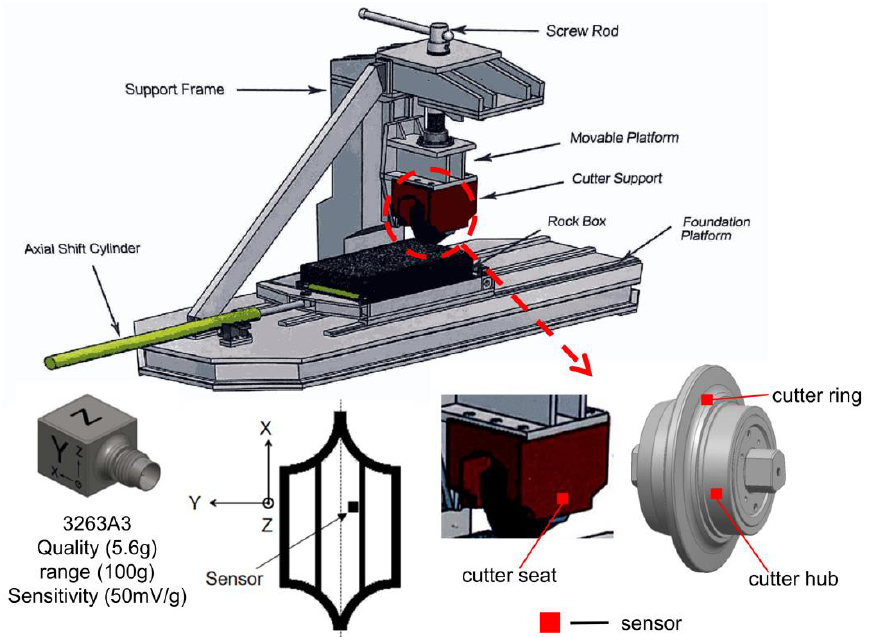
Figure 3. Rock-breaking cutter test bench, and corresponding sensor parameters and layout.